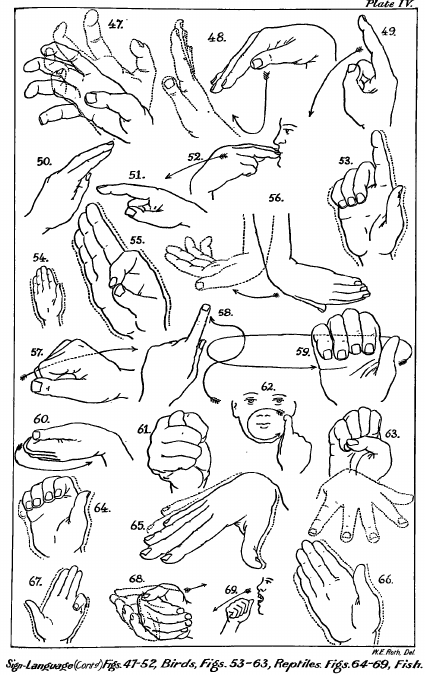
Figure 9. Samples of gestural signs denoting birds, reptiles and fish, as illustrated by W. E. Roth, Plate IV, Ethnological Studies among the North-West-Central Queensland Aborigines , 1897.